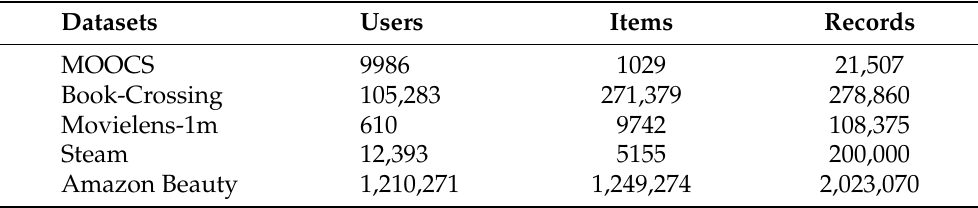
Table 1. The statistics of the five datasets.